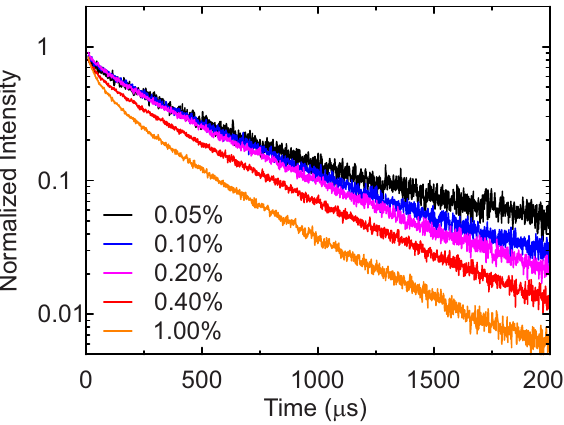
Figure 4. Normalized luminescence intensity decay at 20 ◦ C for samples with different doping concentrations.